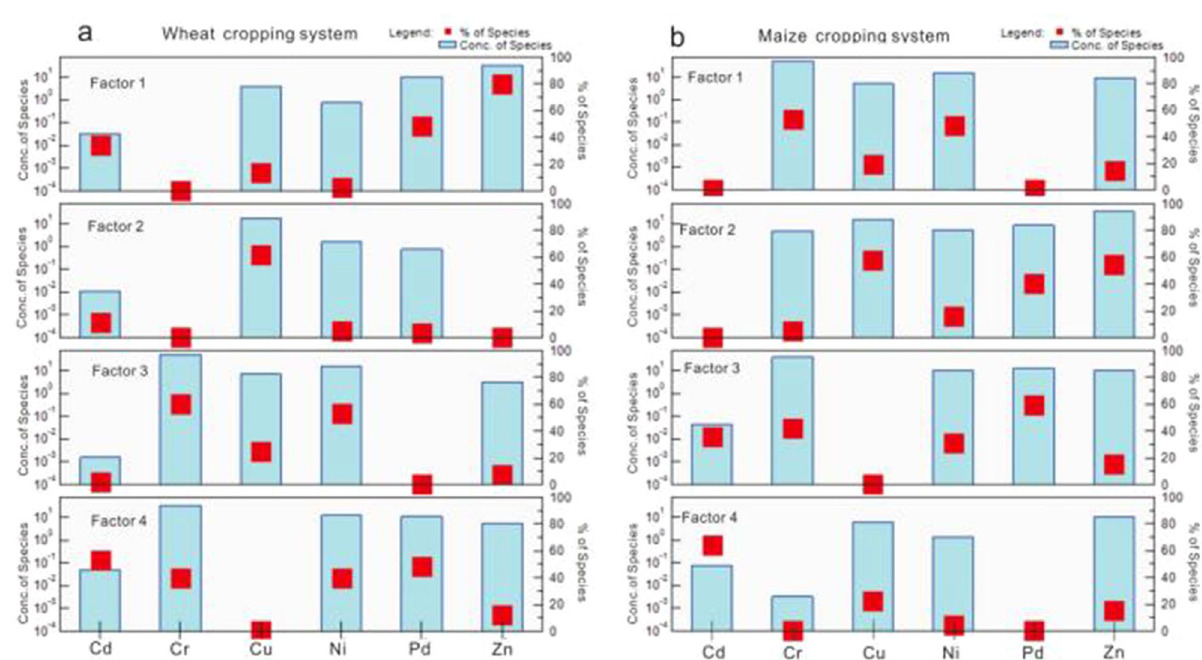
Figure 2. Factor profile of heavy metals in ( a ) wheat and ( b ) maize cropping systems based on a positive matrix factorization